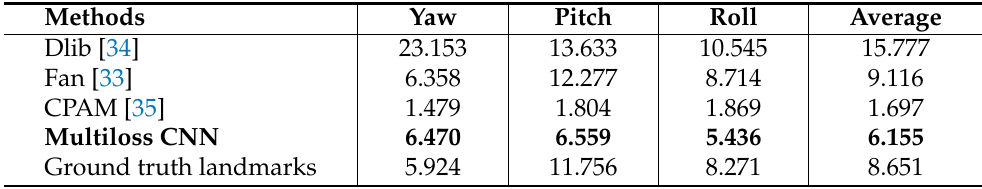
Table 1. Mean average error of Euler angles across different methods on the AFLW2000 dataset.